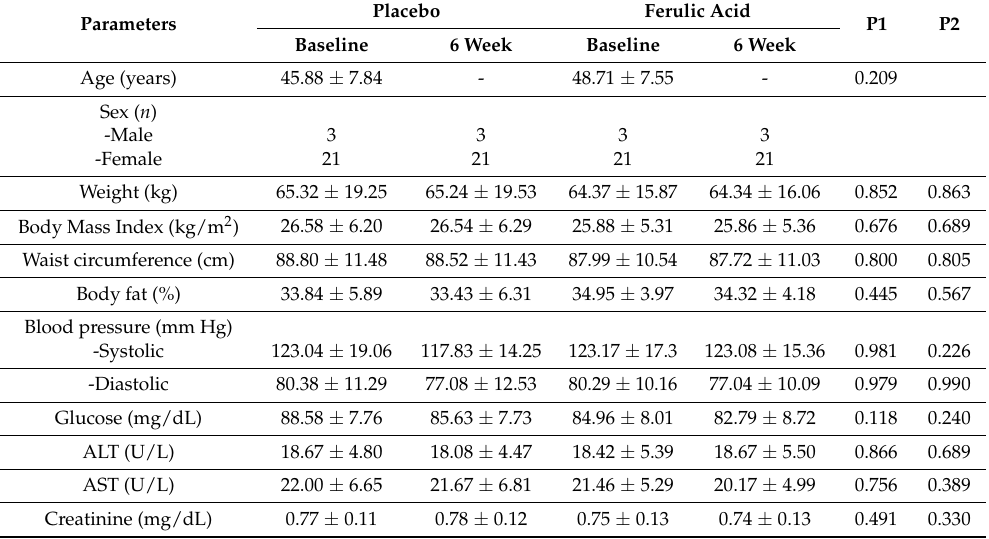
Table 1. General Characteristics and Blood Chemistry of Subjects.